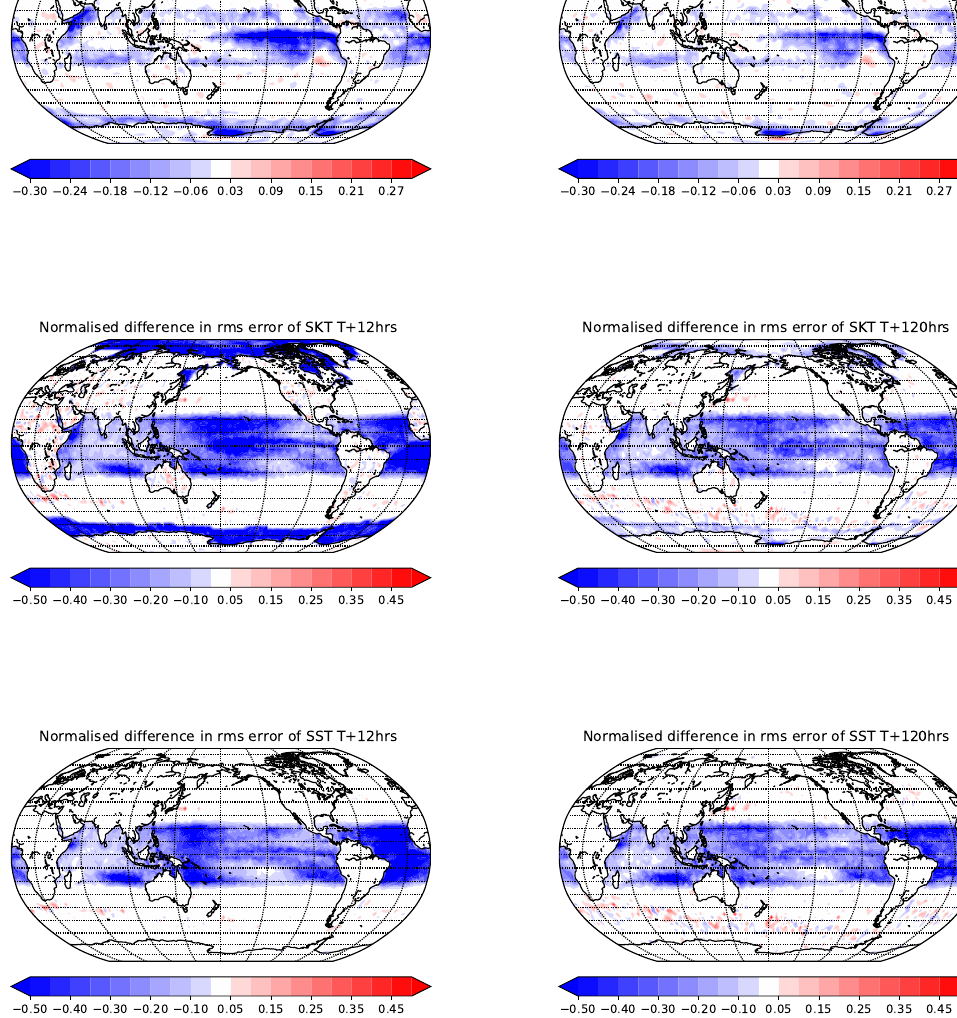
Figure 7. Spatial maps of the normalised difference in RMSE between WCDA and the control for temperature at 1000 hPa ( top ), skin temperature ( middle ) and sea-surface temperature ( bottom ) forecasts at 12 h ( left ) and 120 h ( right ) lead times (48 h lead time for temperature at 1000 hPa), for the period from 9 June 2017 to 21 May